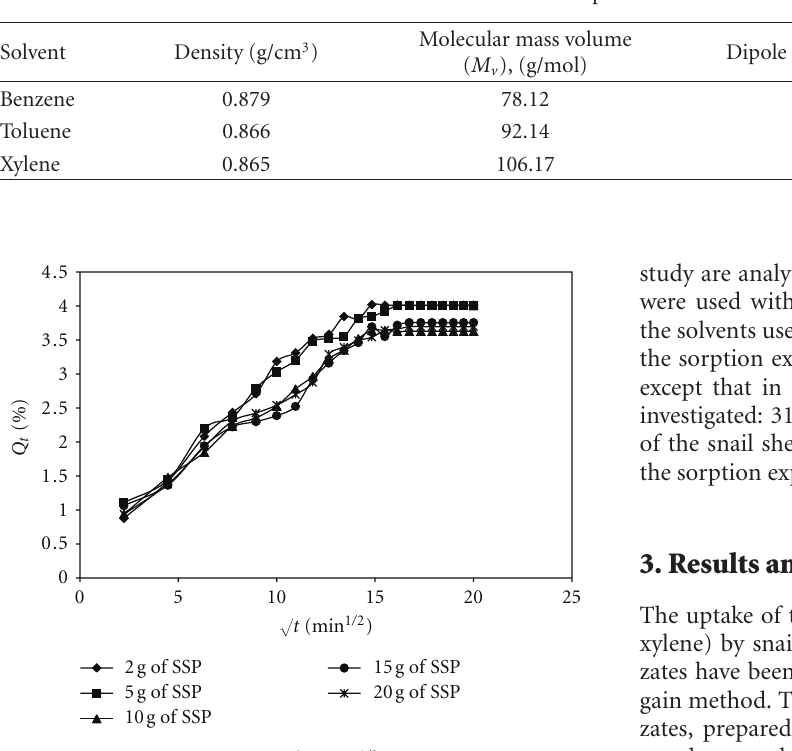
Figure 1: Plot of % Q t versus (particle size, 0.075 μ m) filled natural rubber in benzene at di ff erent filler content at 313